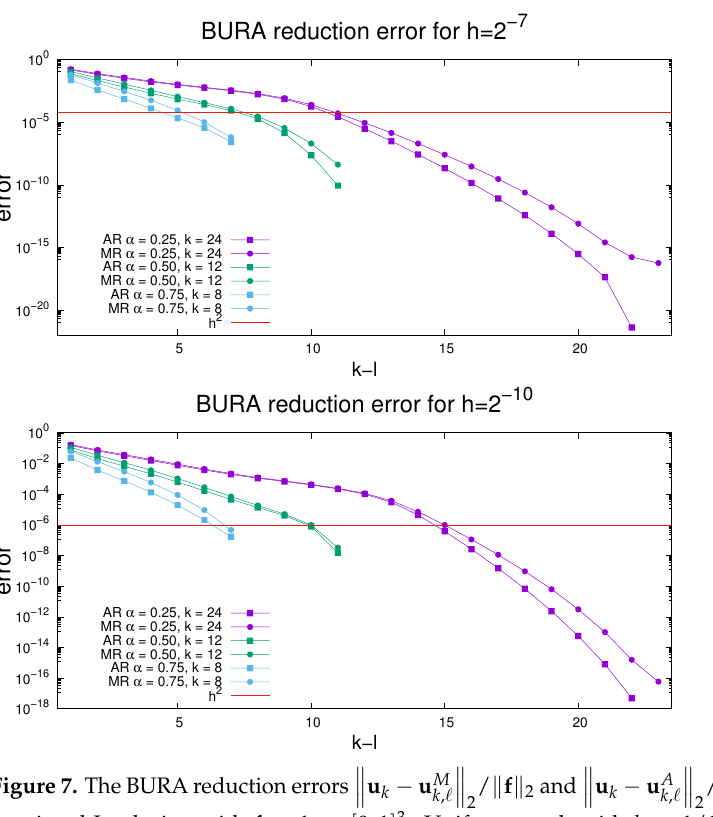
Figure 7. The BURA reduction errors fractional Laplacian with f ≡ 1 on [ 0,1 ] 3 . Uniform mesh with h = 1/128 ( top ) and h = 1/1024 ( bottom ) is